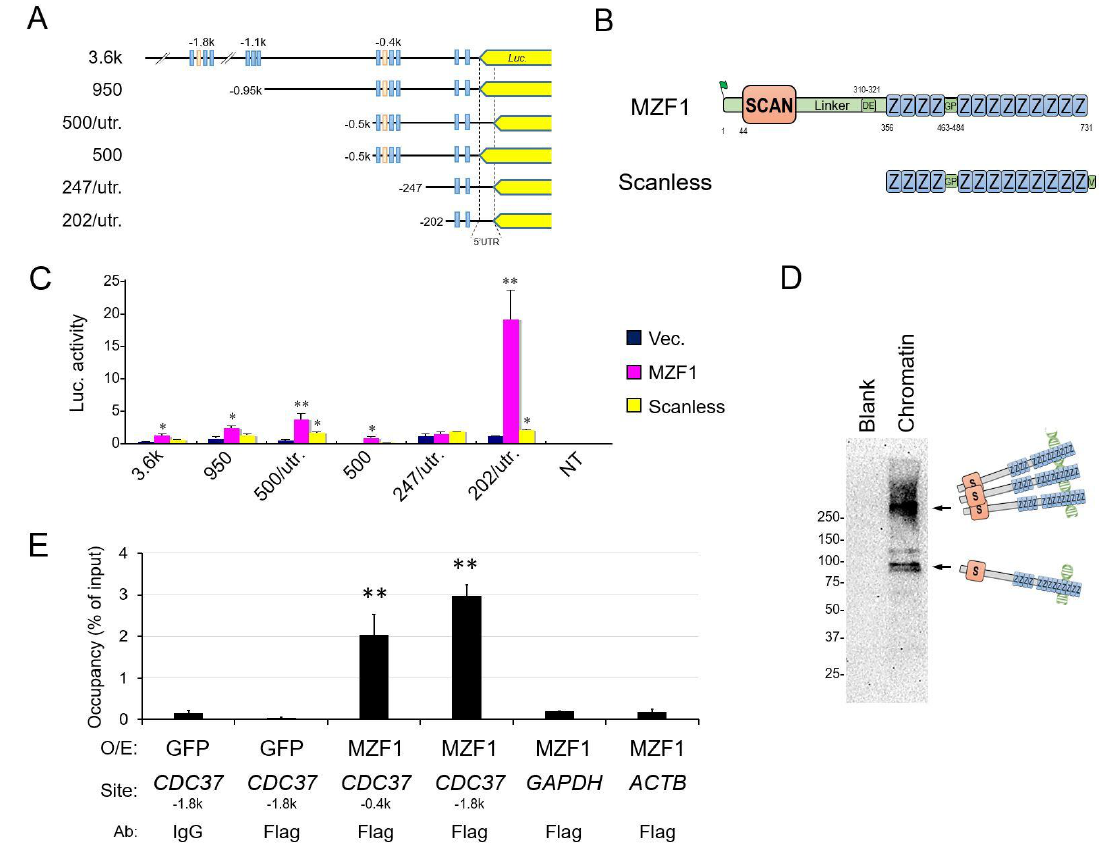
Figure 2. SCAN zinc finger MZF1 directly trans -activates the CDC37 gene. ( A ) Schemes of the